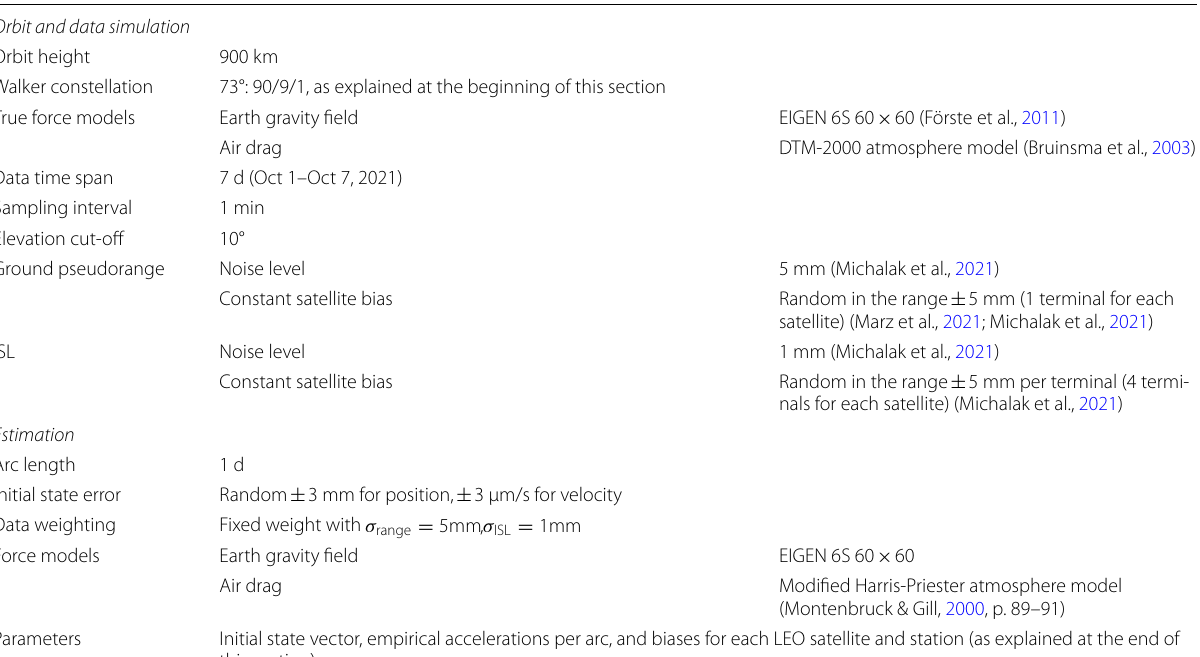
Table 1 Simulation and estimation